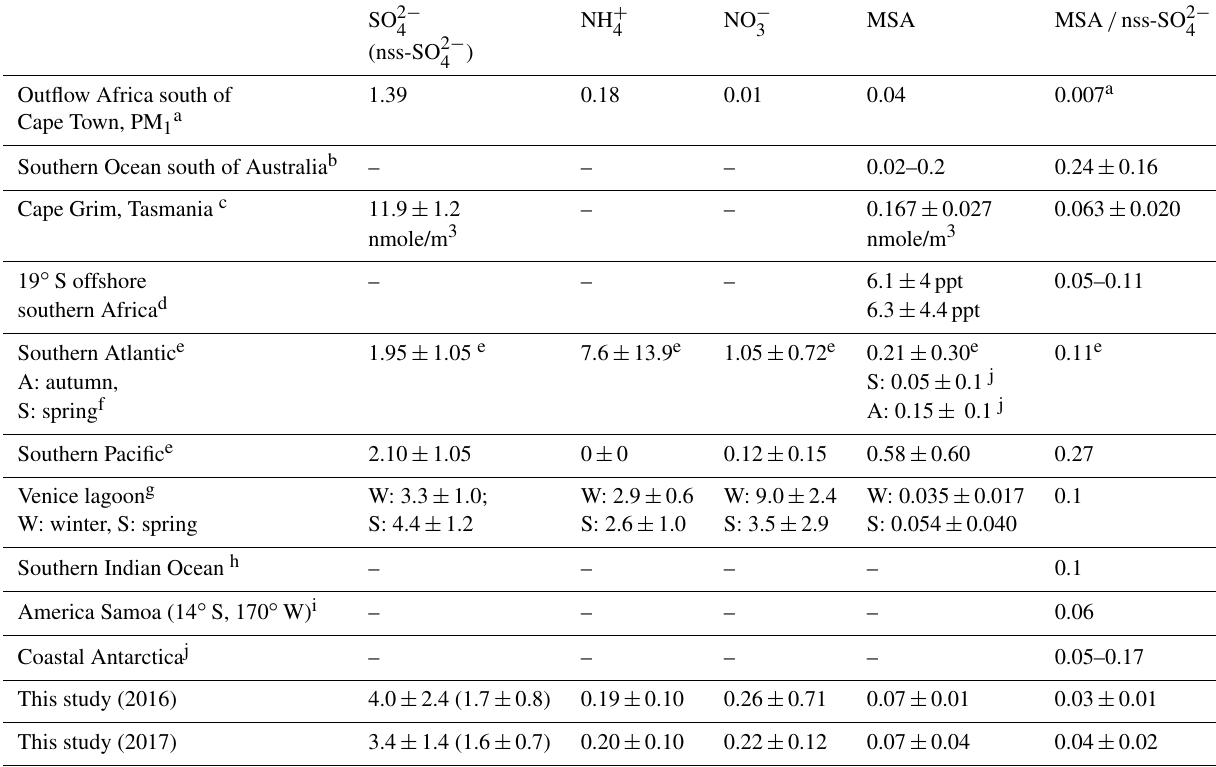
Table 4. Reported concentrations for marine biogenic and secondary aerosols for different locations, and especially in the Southern Hemi- sphere. Concentrations are in µgm − 3 unless stated